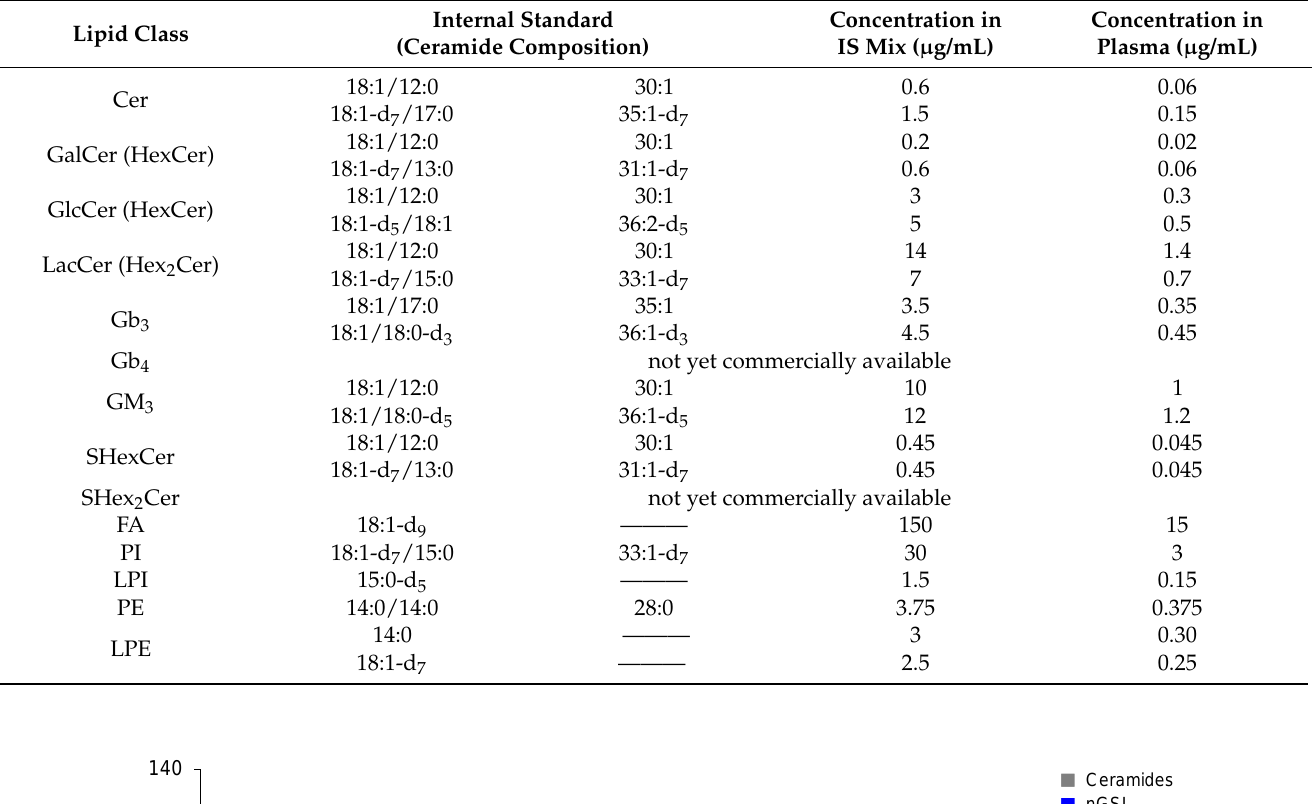
Table 3. Internal standards (IS) concentrations in internal standard mixture (IS Mix) and plasma for individual lipid subclasses.